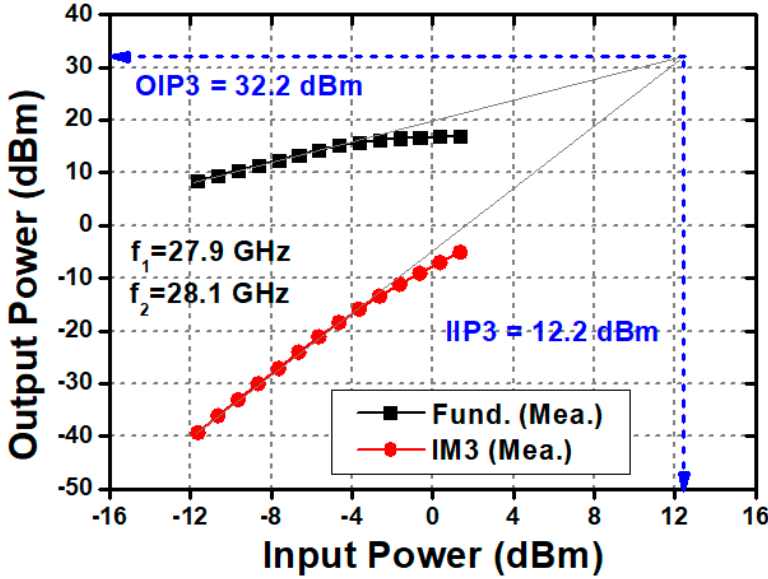
Figure 13. Measured IB OP1dB performance at f RF ( f RF = 28 GHz). Black dot: Fund. Red dot: IM3.